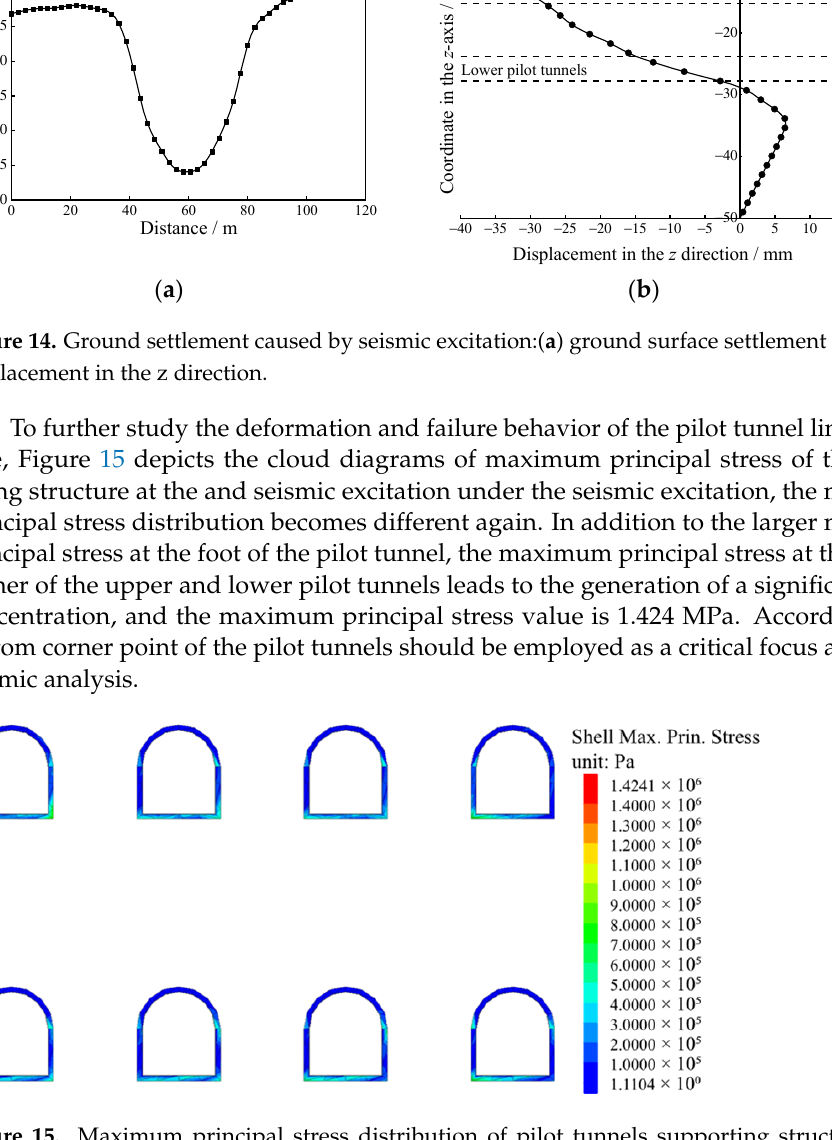
Figure 14. Ground settlement caused by seismic excitation:( a ) ground surface settlement ( b ) ground displacement in the z direction.